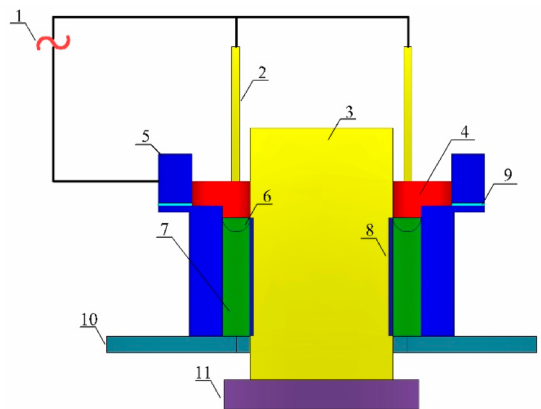
Figure 1. Schematic diagram of an electroslag remelting cladding (ESRC) device. 1-electrical source, 2-electrode, 3-mandrel, 4-liquid slag, 5-current carrying mold, 6-melting steel, 7-working layer, 8-fusion